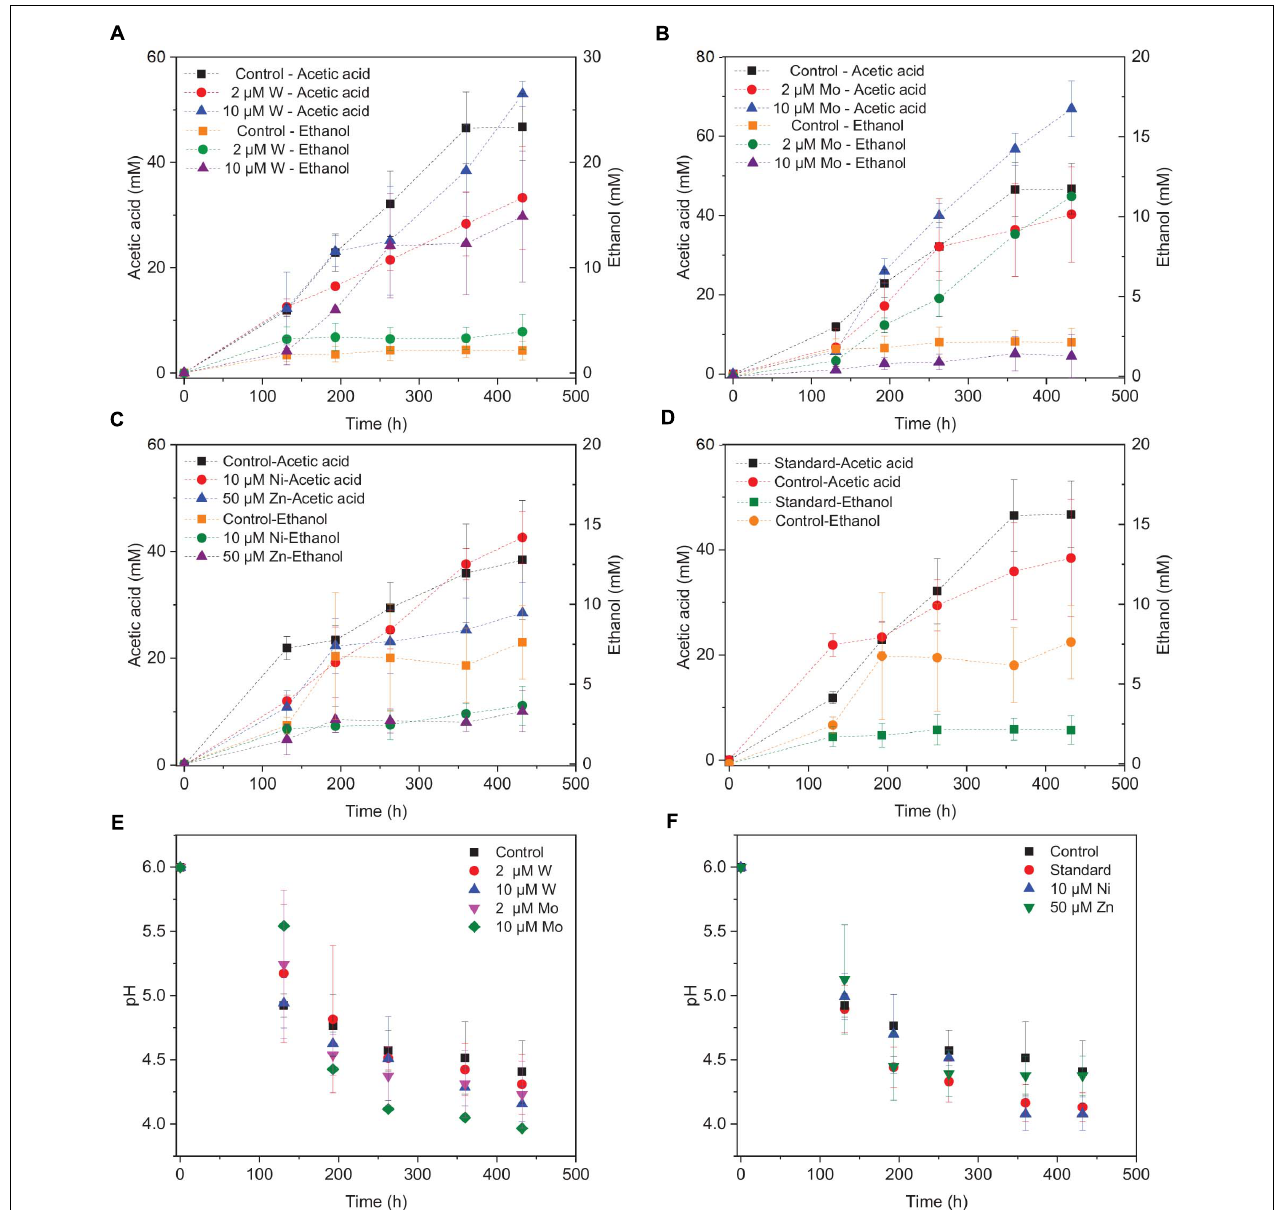
FIGURE 4 | Acetic acid and ethanol production by heat-treated granular sludge using H 2 /CO 2 as the substrate at 25 ◦ C with the addition of (A) 2 µ M, 10 µ M W, (B) 2 µ M, 10 µ M Mo, (C) 10 µ M Ni, 50 µ M Zn, (D) No trace metals, and (E,F) change of